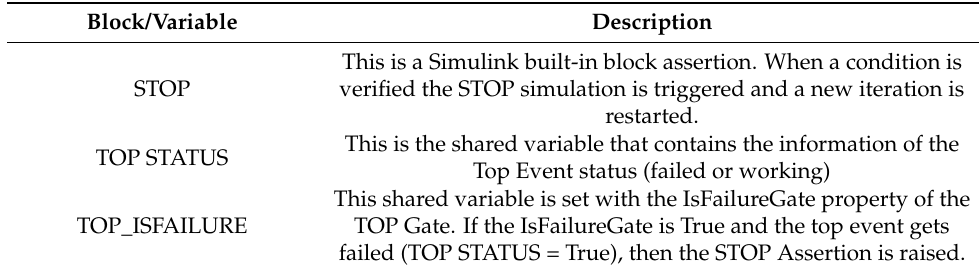
Table 3. Main elements of the “generic hybrid basic event” block.